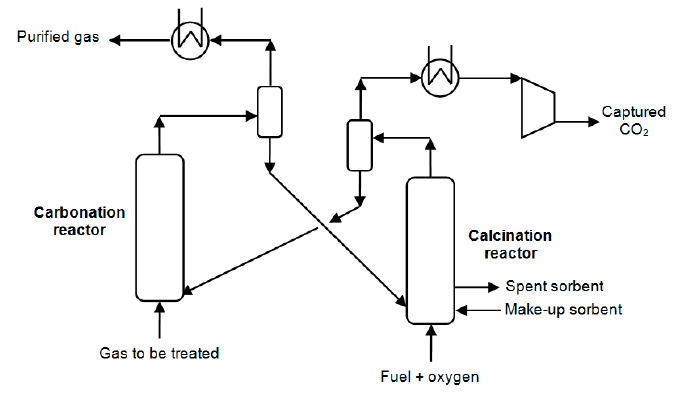
Figure 2. CO 2 capture by the calcium-based sorbent looping cycle.